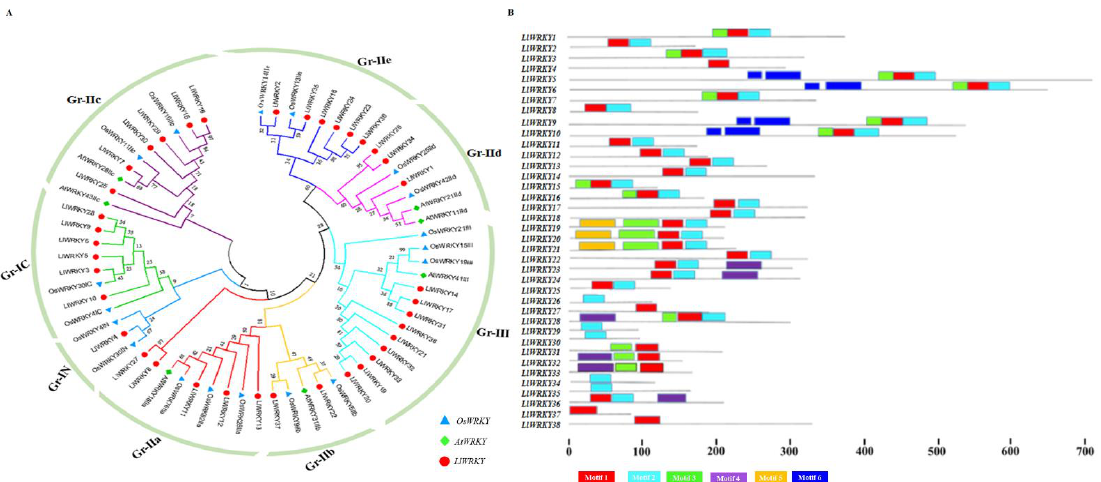
Figure 2. Unrooted phylogenetic tree analysis of WRKY proteins: ( A ) Lilium (38), rice (19), and Arabidopsis (7); ( B ) conserved motifs of 38 LlWRKY proteins. The phylogenetic tree was constructed using MEGA7. Different colors represent different groups and red circles represent LlWRKY, blue triangles represent OsWRKY and green squares represent AtWRKY proteins. MEME was used to predict motifs, and boxes represent these motifs.